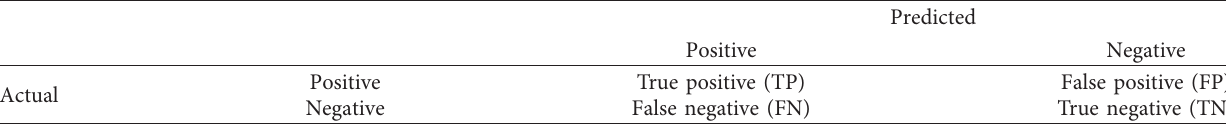
Table 2: Confusion